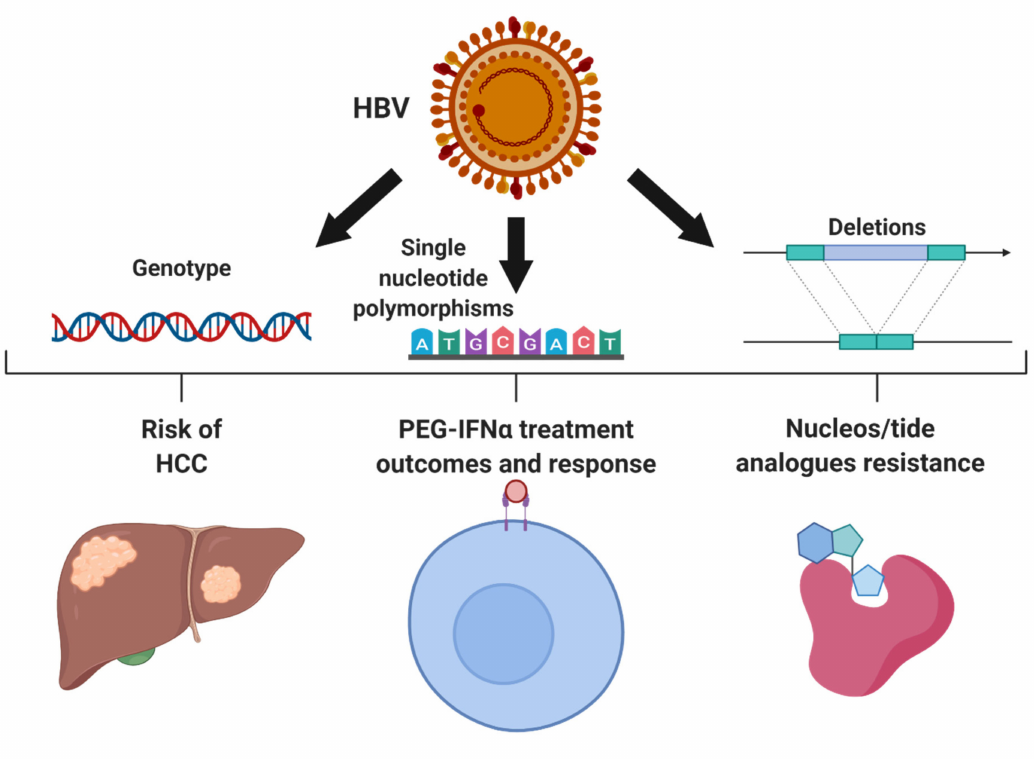
Figure 2. Impacts of Hepatitis B Virus (HBV) genetic variants including genotype, single nucleotide polymorphisms, and deletions of genetic regions. Certain genotypes of HBV are recognized to have higher risks of hepatocellular carcinoma (HCC) and better outcomes to anti-HBV therapeutics such as pegylated-interferon alpha (PEG-IFN α ). Similarly, viral genetic polymorphisms particularly in the HBV X / basal core promoter / precore region and the surface region influence HCC risks, PEG-IFN α therapy and viral resistance to nucleos / tide analogues (NA). Figure constructed using